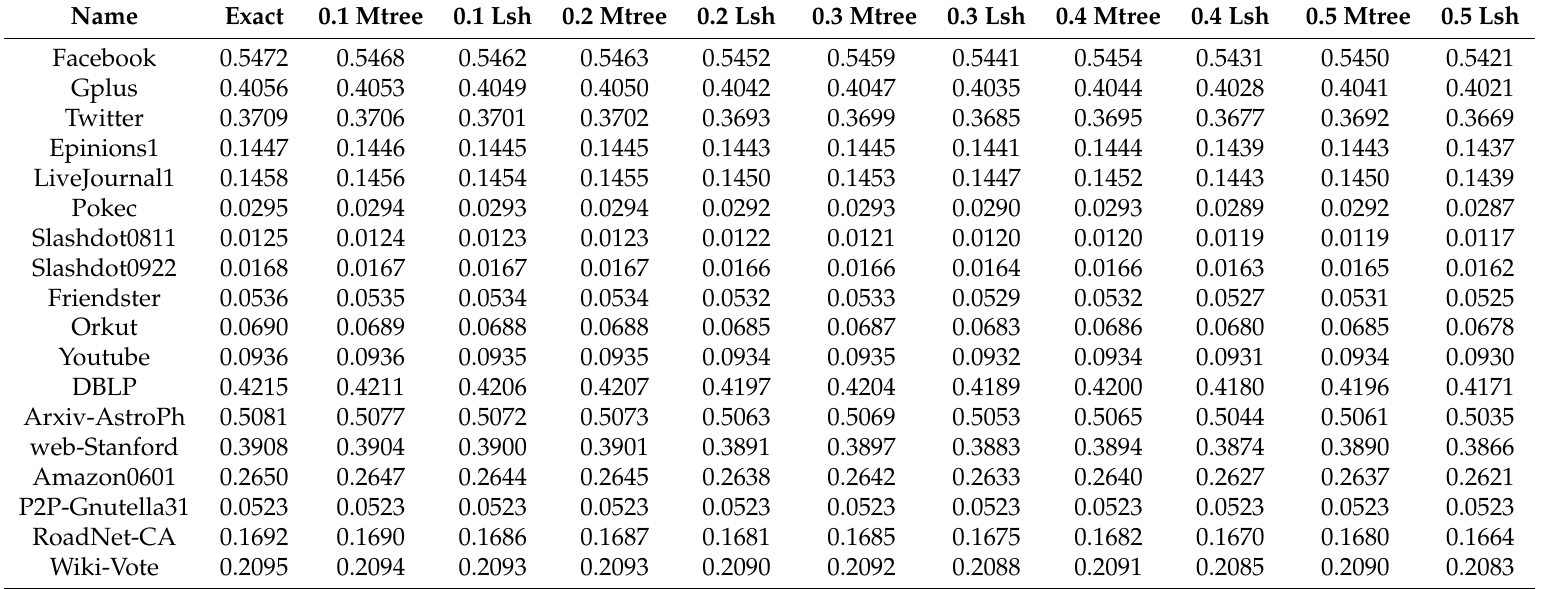
Table 4. Experiment 2: Experiment on